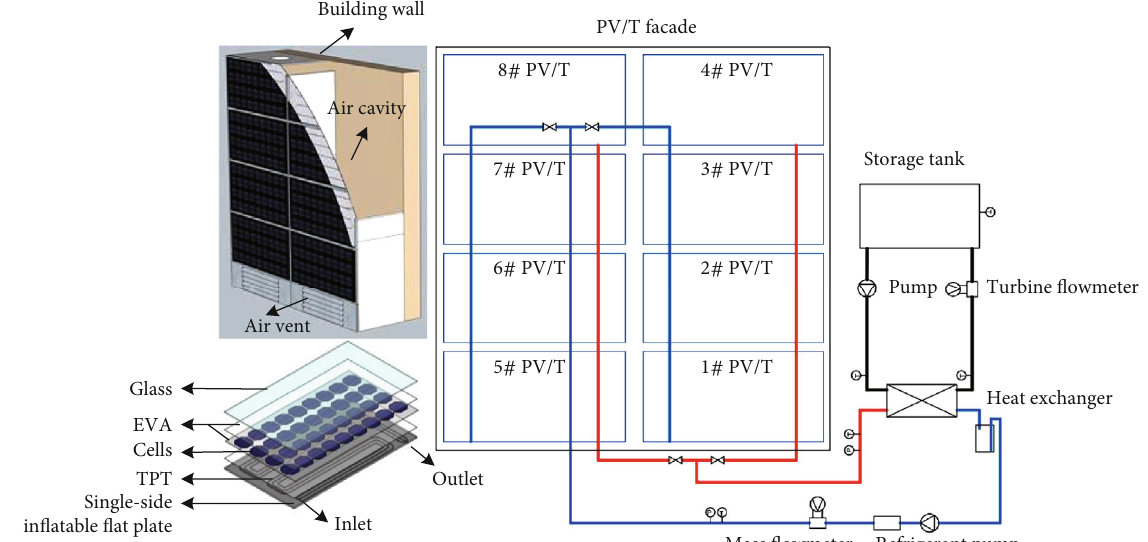
Figure 1: The connection form of the PV/T façade system before improvement